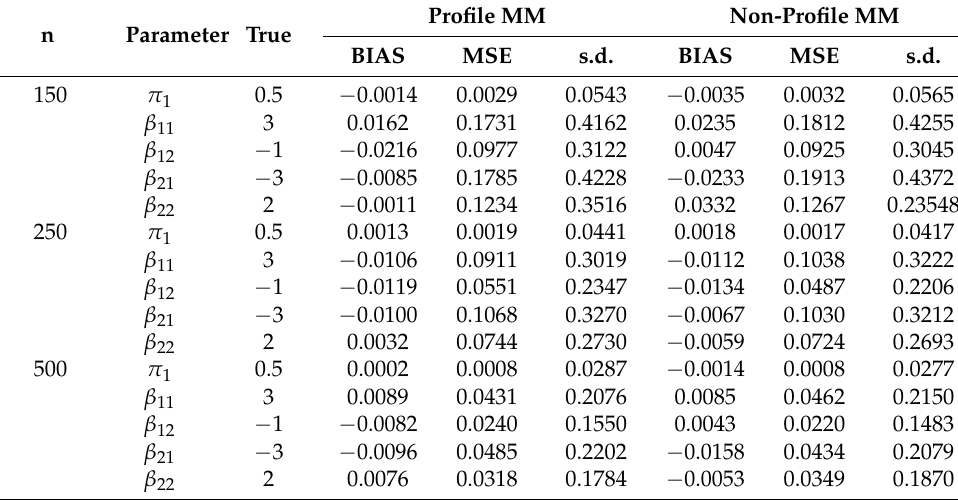
Table 2. Parameter estimation results in Scenario